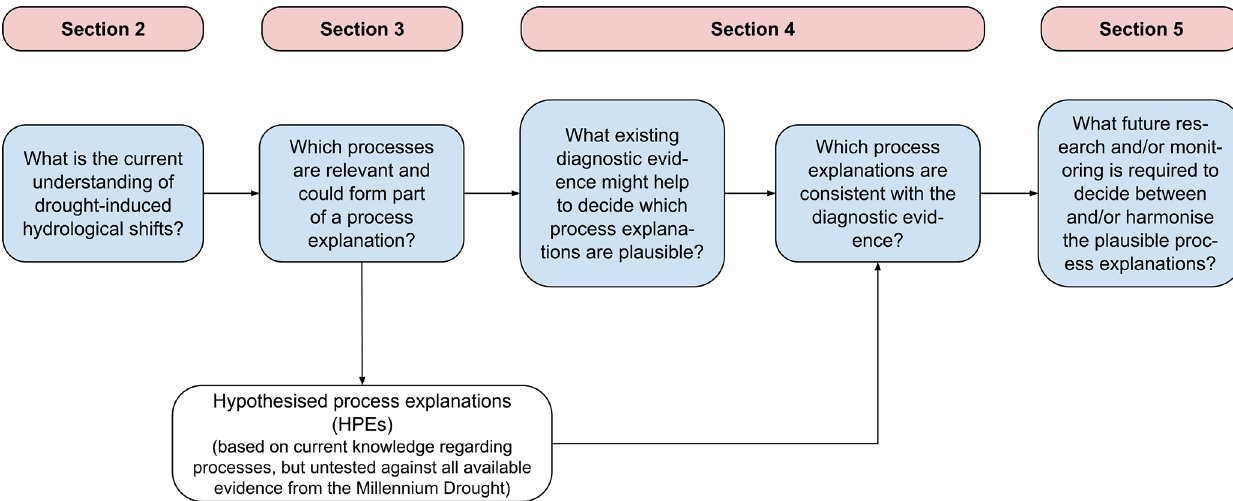
Figure 1. Key questions for each section in this